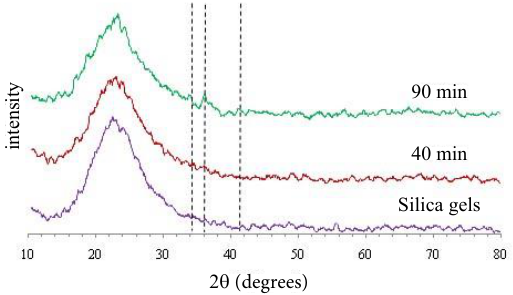
Fig. 4. XRD patterns of silica gel and CuO/SGn